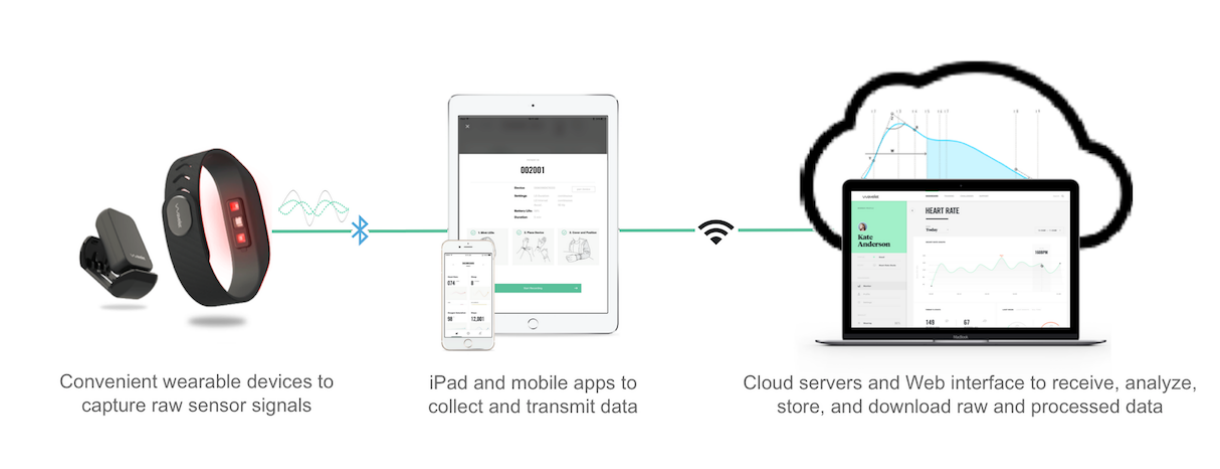
Figure 1. The data collection platform comprises wearable and connected devices that use low energy Bluetooth technology to communicate with the mobile and computer tablet software apps to collect and transmit raw sensor data and cloud servers; algorithms; and a Web interface to analyze, store, and access